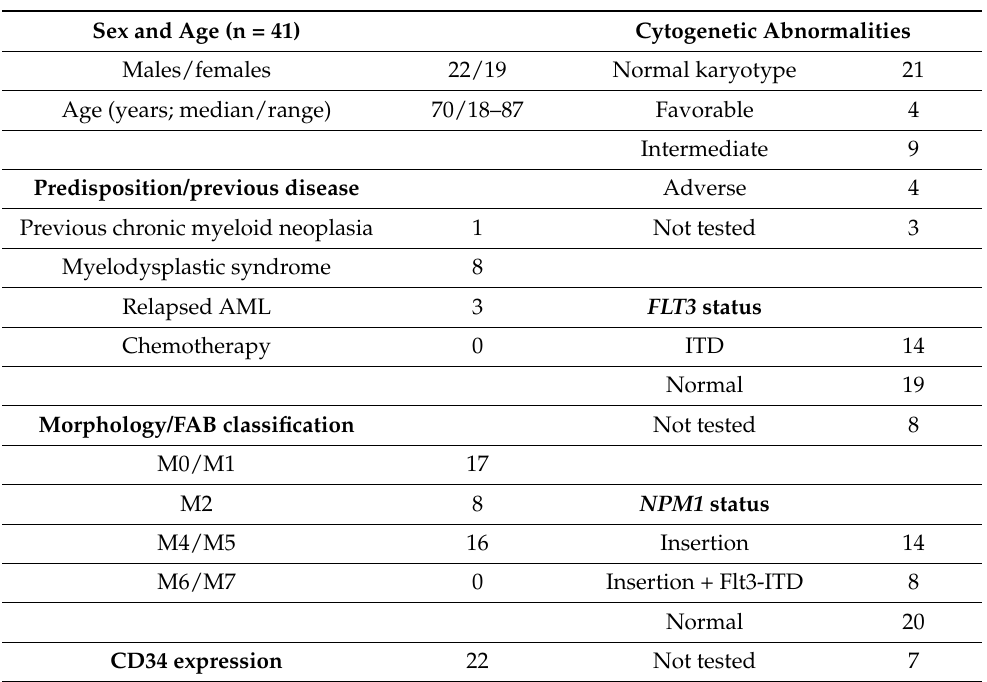
Table 1. Clinical and biological characteristics of the 41 AML patients included in the study. Unless otherwise stated, the results are presented as the number of